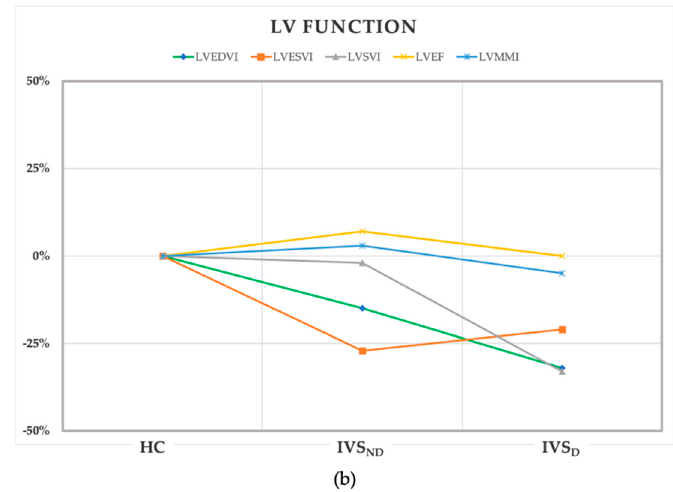
Figure 2. The trend of the percentage changes in the RV ( a ) and LV ( b ) function from the HC to IVS D group. All of the values of the coordinate points were calculated from the percentage change of the median of the parameters in the IVS ND and IVS D groups using the HC as the baseline. HC, health control; IVS ND , pulmonary hypertension patients without interventricular septum displacement; IVS D , pulmonary hypertension patients with interventricular septum displacement; RV, right ventricle; LV, left ventricle; EDVI, end-diastolic volume index; ESVI, end-systolic volume index; SVI, stroke volume index; EF, ejection fraction; MMI, myocardial mass index; VMI, ventricular mass index.